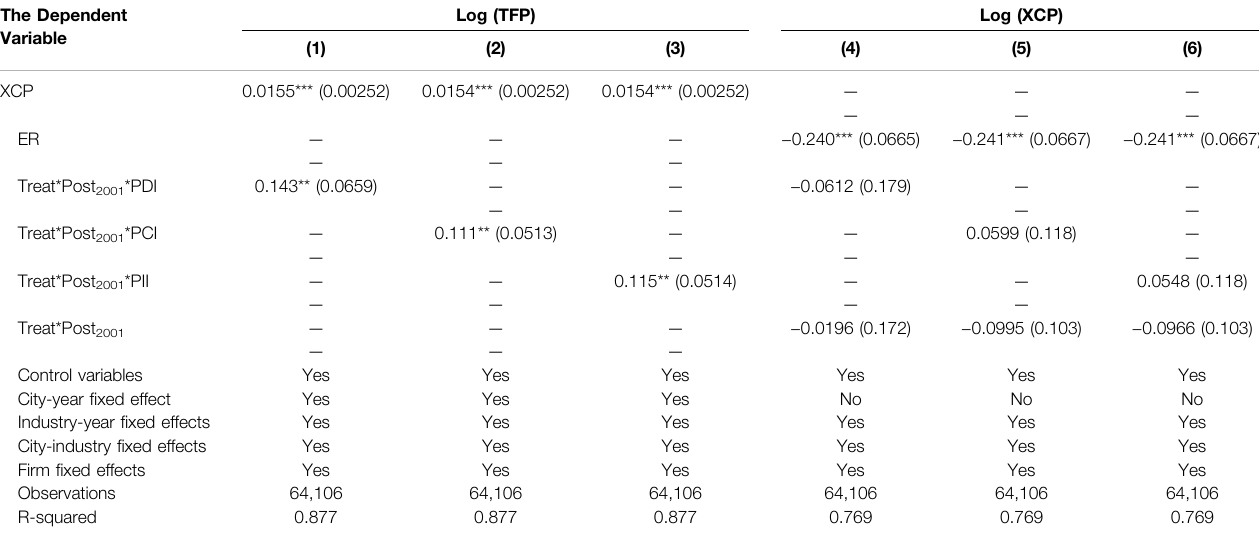
TABLE 3 | Testing for Porter hypothesis. The Dependent